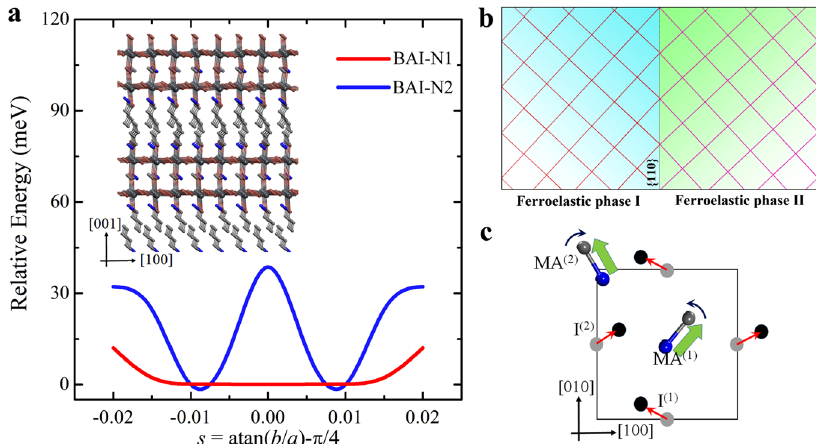
Fig. 3 DFT results of ferroelasticity in layered perovskites. a Relative energy per simulation supercell with respect to ferroelastic strain s for BAI-N1 (red curve) and BAI-N2 (blue curve) structures. The inset shows the relaxed atomic geometric structure (hydrogen atoms are removed) of BAI-N2. b Ferroelastic domain between two phases. c MA rotations induced ferroelasticity. The solid gray and black circles represent I atoms before and after distortions, and the green arrows show the polarization of MA